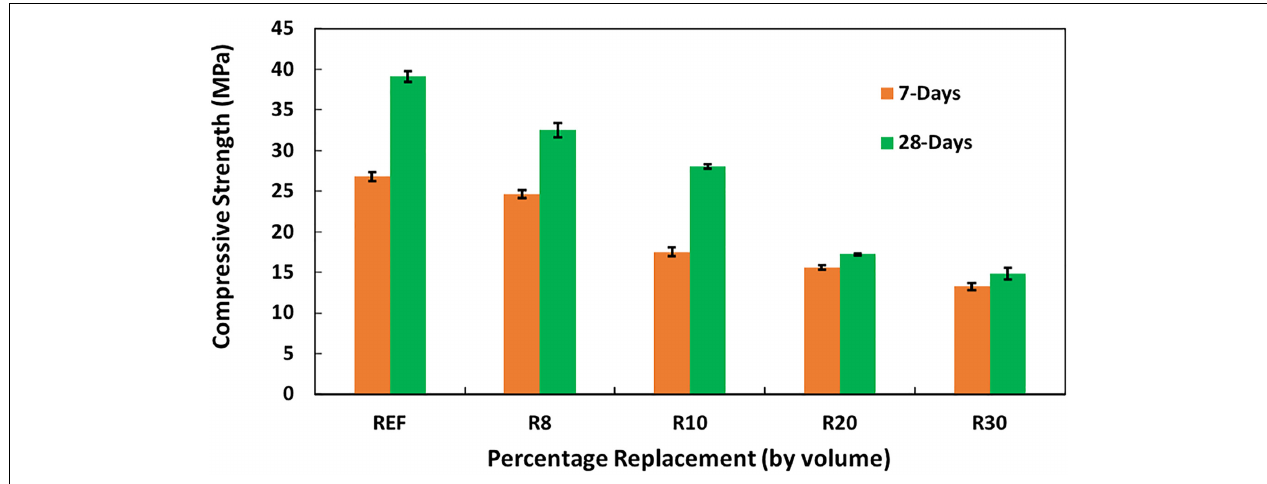
FIGURE 4 | 7- and 28-days compressive strength of trial concrete mix with made different rubber content.